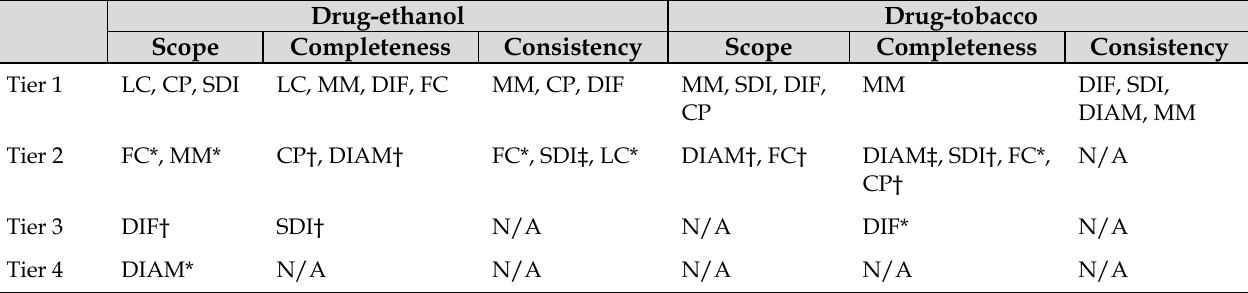
Table 4 Tier analysis